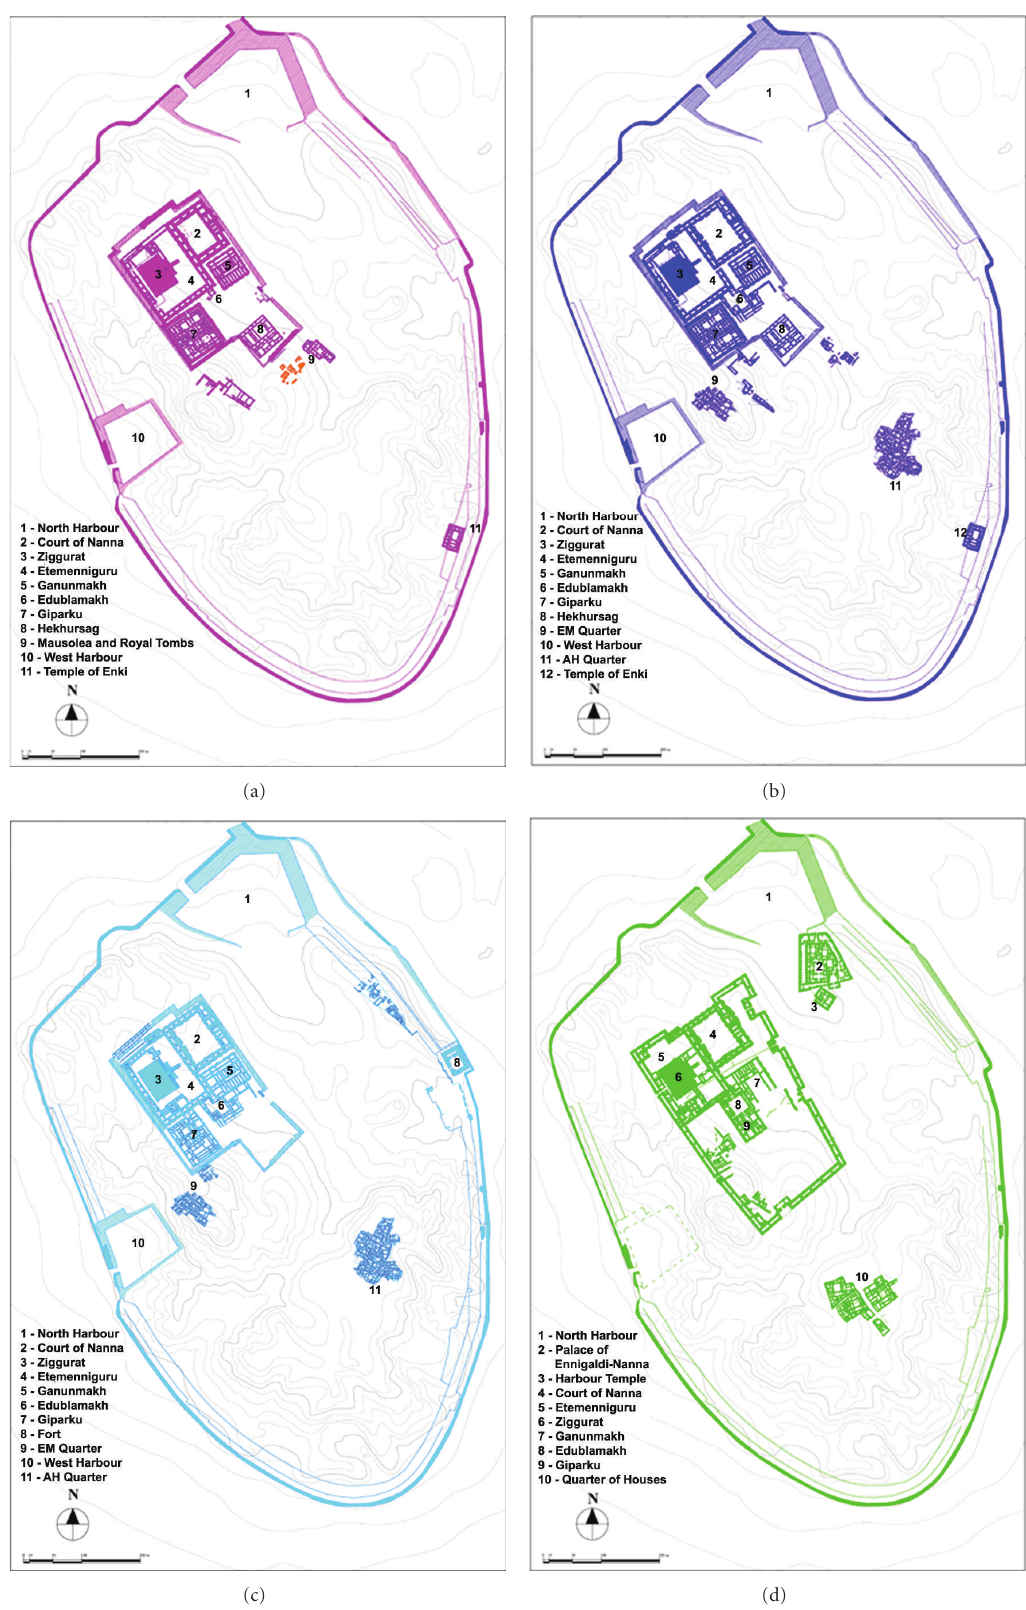
Figure 8: Maps of the main phases of Ur: (a) the Sumerian period, from the 1st to the 3rd Dynasty; (b) the Isin and Larsa Dynasties; (c) the Kassite period; (d) the Neo-Babylonian